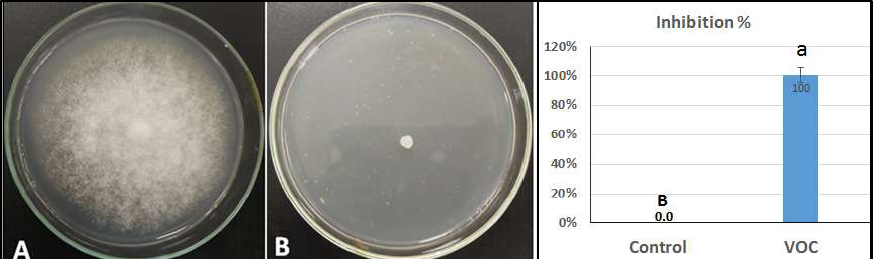
Figure 5. Effect of the extracted volatile organic compounds (VOCs) on the mycelial growth of the test P. infestans isolate. ( A ) Control plate of P. infestans (normal growth); ( B ) VOCs amended (no P. infestans growth). Values in the same bar chart with different letters are significantly different at p < 0.05.